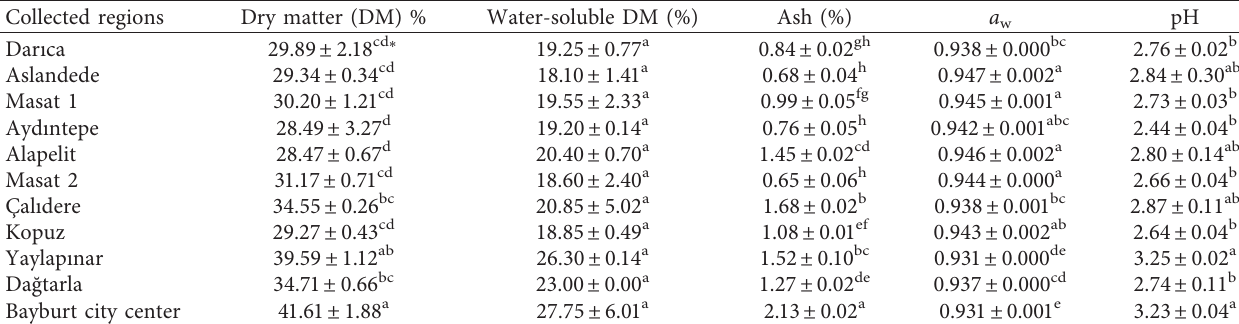
Table 2: Physicochemical properties of Berberis fruits collected from Bayburt province. Collected